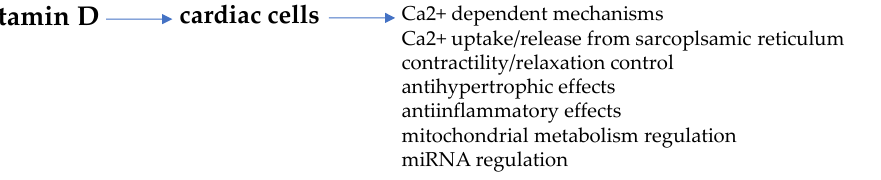
Figure 3. Vitamin D-mediated regulation of cardiac cells. Some important cardiomyocyte functions regulated by vitamin D are targeted by estrogens as well.